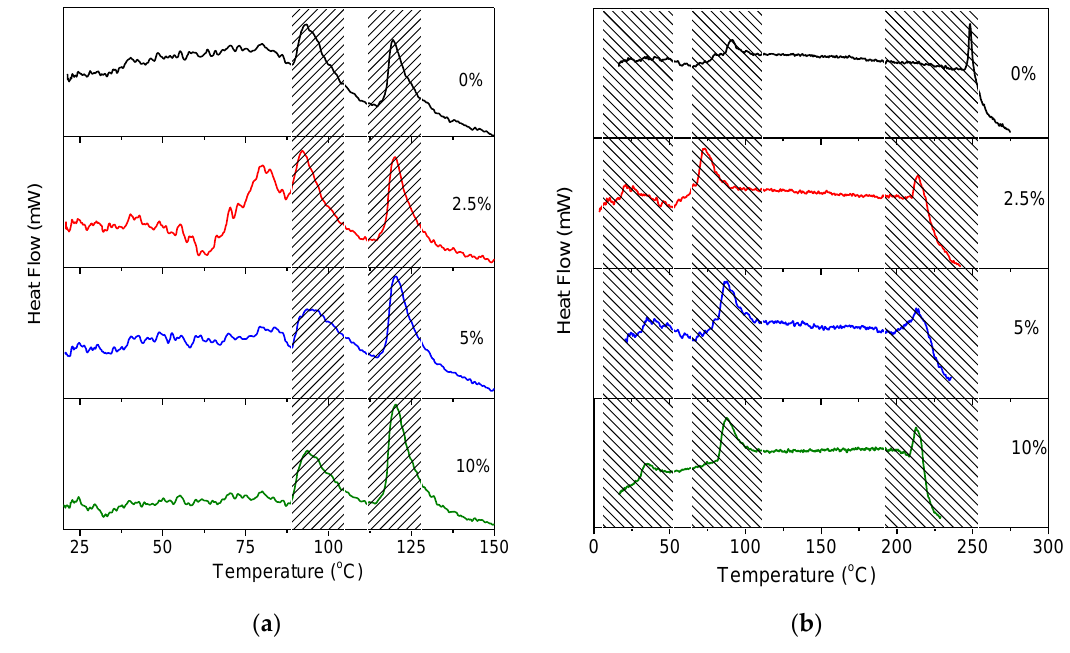
Figure 7. DSC thermogram of ( a ) TBA-Br + Al 2 O 3 and ( b ) TBA-PF 6 + Al 2 O 3 at various Al 2 O 3 concentration.